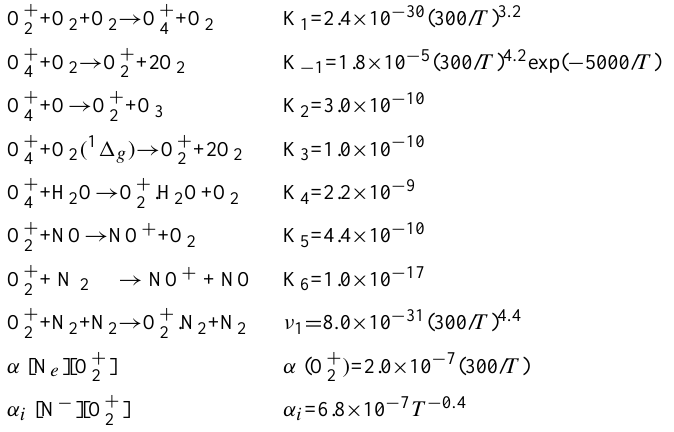
→ CB + and the recombination coefficients α (O + 2 1